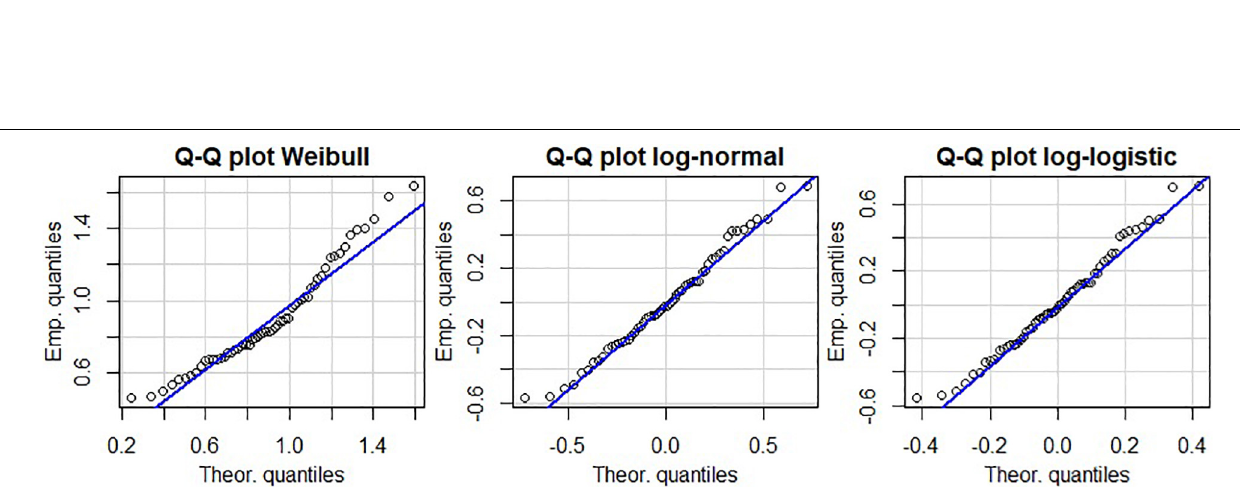
Frontiers in Bioengineering and Biotechnology |